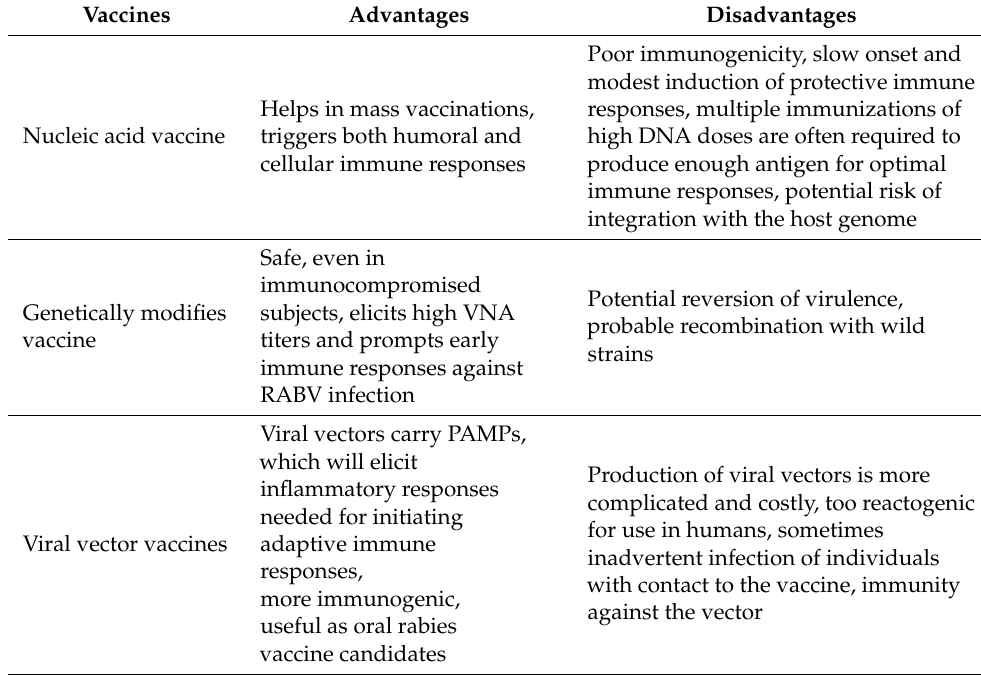
Table 2. Cont. Vaccines Advantages Disadvantages Poor immunogenicity, slow onset and modest induction of protective immune responses, multiple immunizations of Helps in mass vaccinations, high DNA doses are often required to Nucleic acid vaccine triggers both humoral and produce enough antigen for optimal cellular immune responses immune responses, potential risk of integration with the host genome